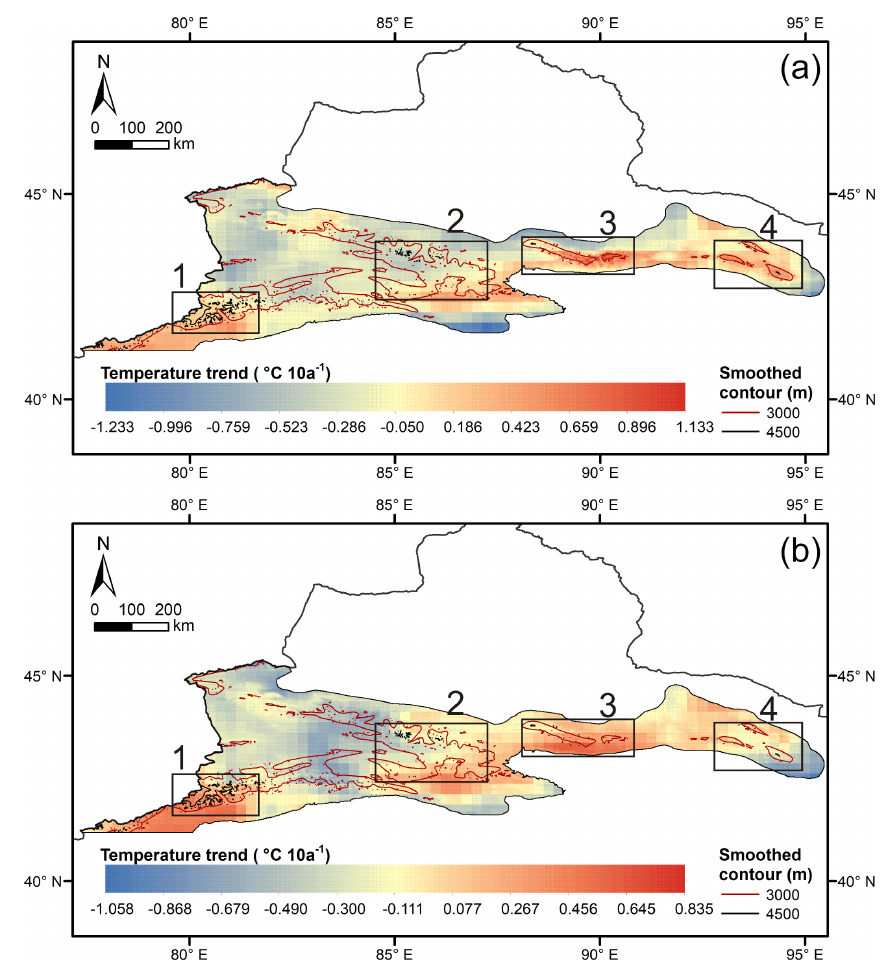
Figure 5. Monthly minimum temperature trends in (a) January and (b) December for the entire CTM from 1979 to